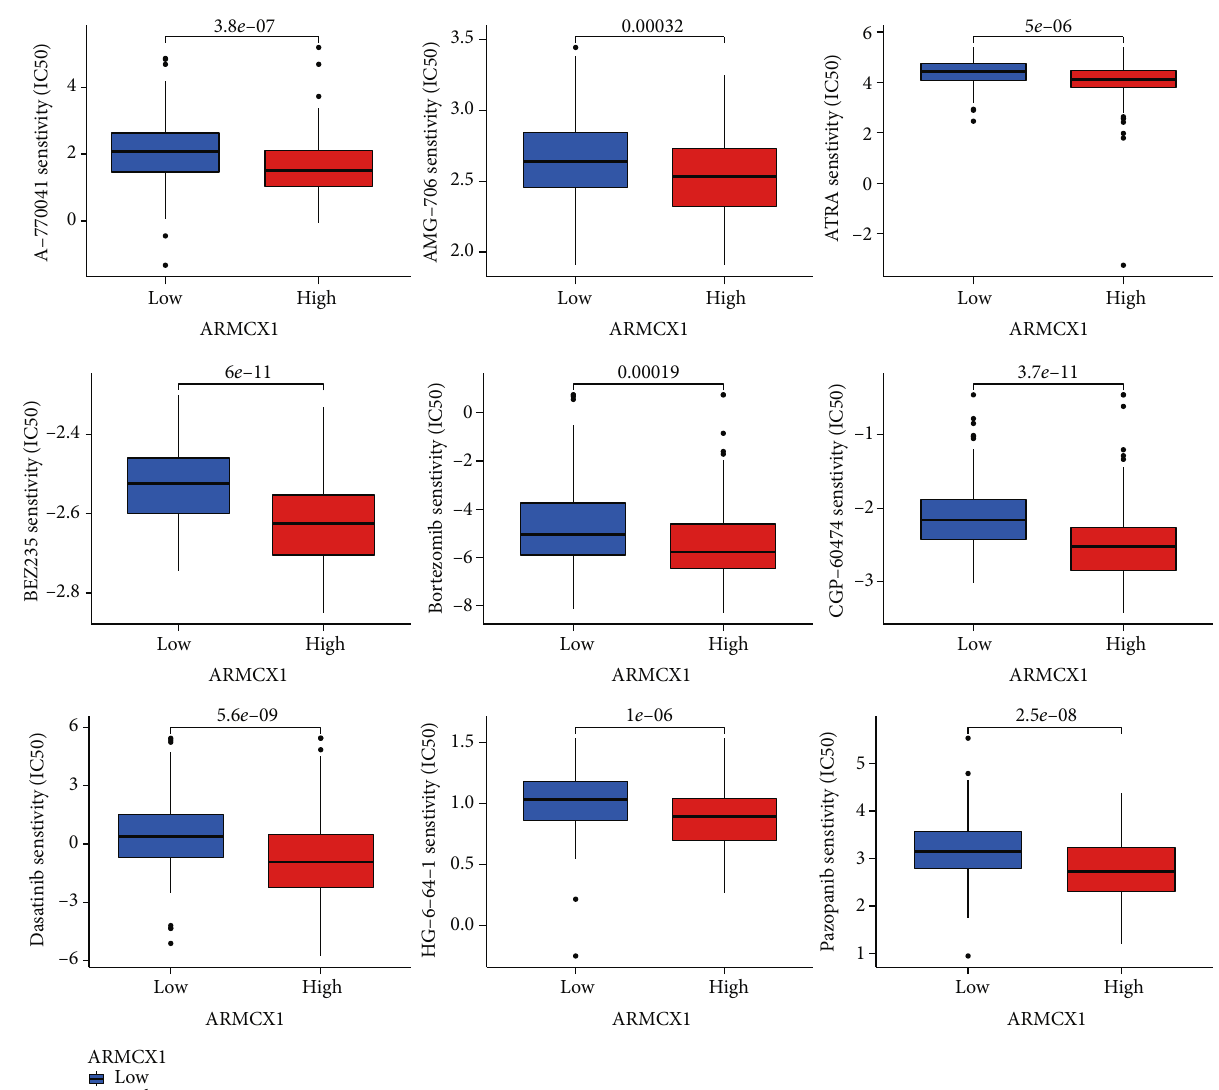
Figure 5: In fl uence of ARMCX1 on chemotherapy against GC. ARMCX1 in fl uenced chemotherapy induced by di ff erent drugs in GC